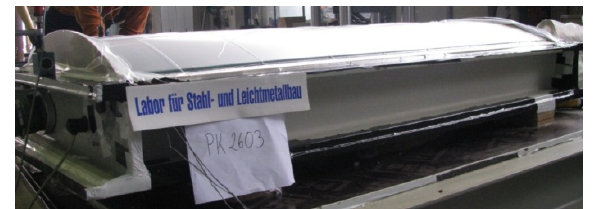
Figure 5: Vacuum test